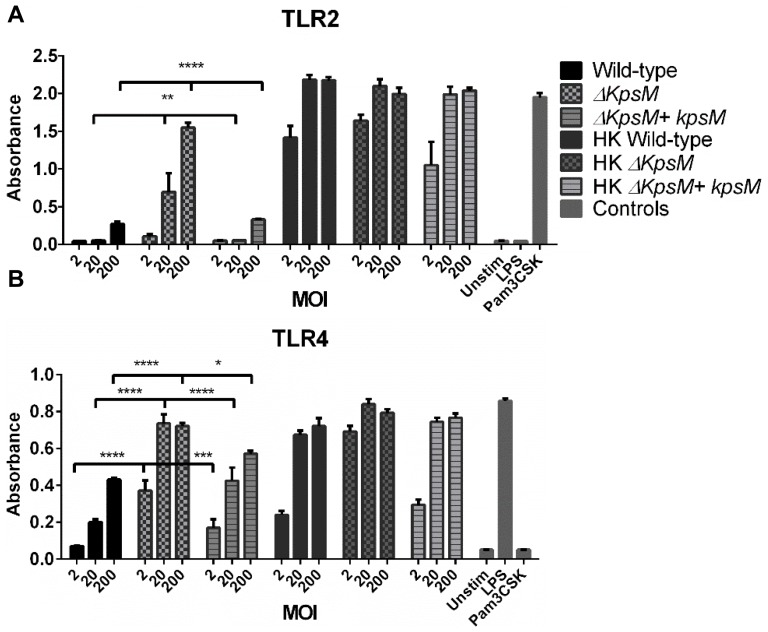
TLR2 and 4 reporter assays.HEK-Blue hTLR2 (A) and HEK-Blue hTLR4 (B) reporter cell lines were exposed for 4 hrs to either live and heat-killed wildtype C. jejuni 81–176, ΔkpsM or ΔkpsM+kpsM. The wild-type C. jejuni stimulates both TLR2 and TLR4 in a dose-dependent fashion. The ΔkpsM mutant significantly increased the signaling by both TLR2 and TLR4, as indicated by the assay, with the increase in stimulation also being in a dose-dependent manner, except for the TLR4 assay where the readers were near the maximum for both the 20 and 200 MOI readings. The complemented ΔkpsM+kpsM strain completely restored the wild-type phenotype with TLR2 and mostly restored the phenotype with TLR4. Values represent the mean of three independent experiments and statistical significance was determined by a two-way ANOVA with a Bonferroni post-test. (* p<0.05, ** p<0.01, *** p<0.001, **** p<0.0001).